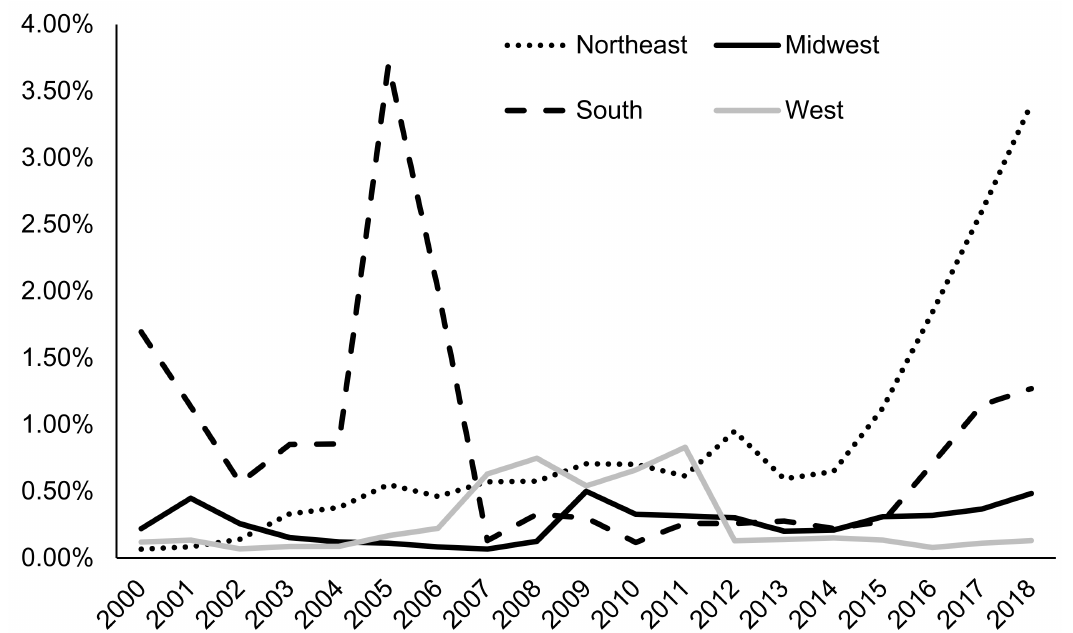
Figure 4. Prevalence of naltrexone treatment prescribed in alcohol use disorder (AUD) admissions from 2000–2018 by region of admission using TEDS-A data. Temporal trends were significant by the Cochran–Armitage trend test ( p <